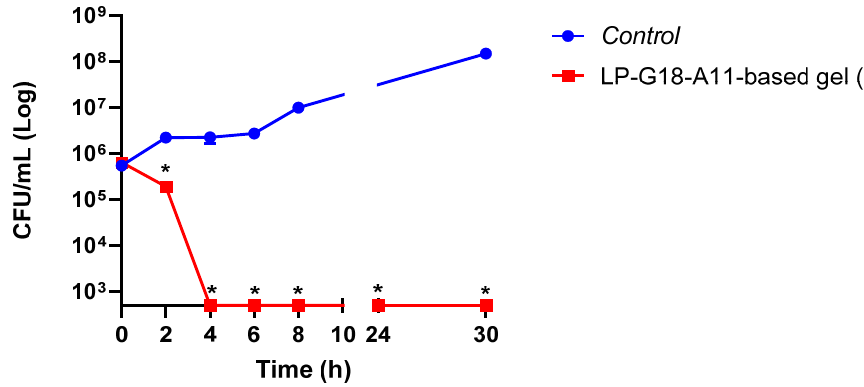
Figure 2. Time-death curve of L. plantarum LP-G18-A11-incorporated gel (5%) against S. aureus . * Significant difference in relation to the growth control ( p < 0.05).